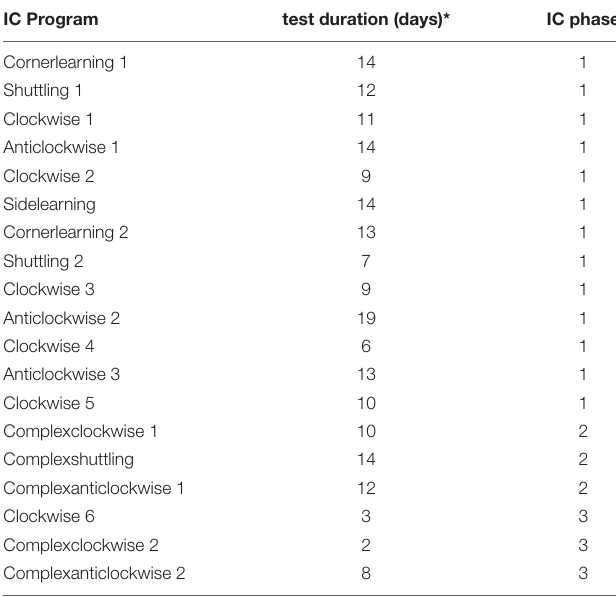
TABLE 1 | Learning IntelliCage tasks assigned to learner mice within the